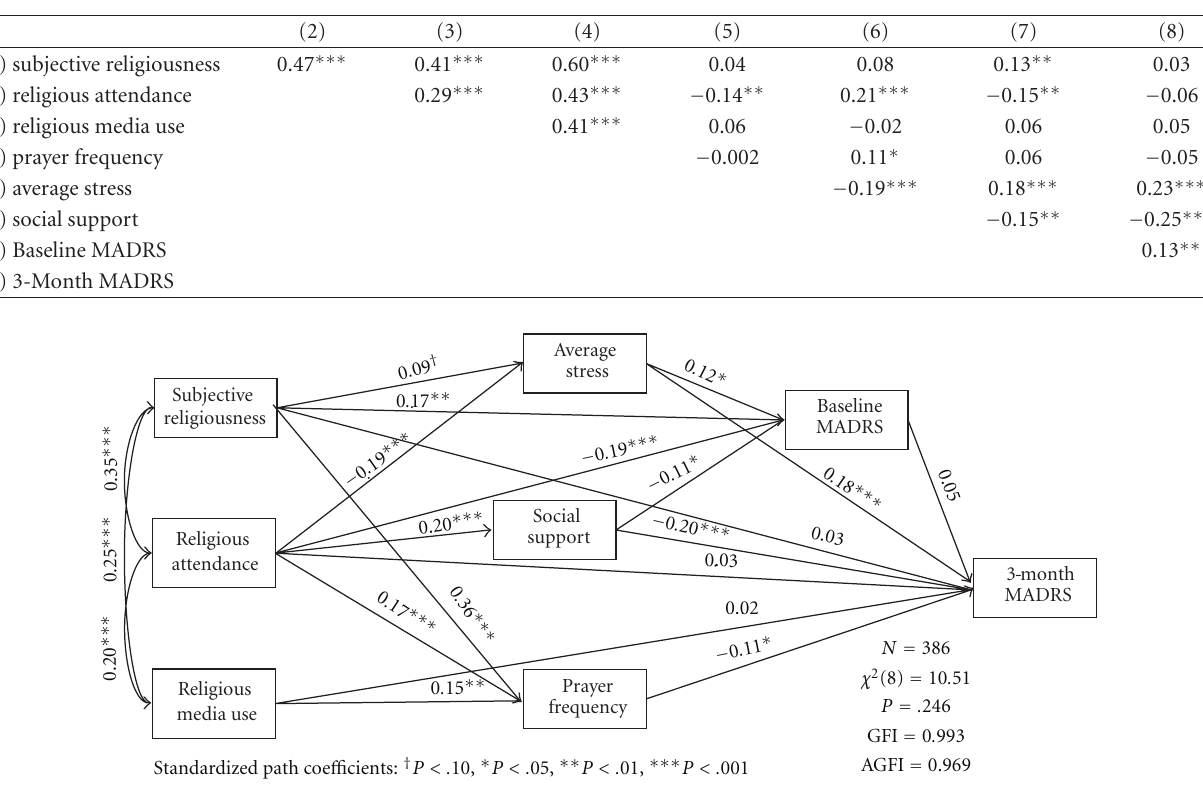
Table 2: Bivariate correlations between study variables.